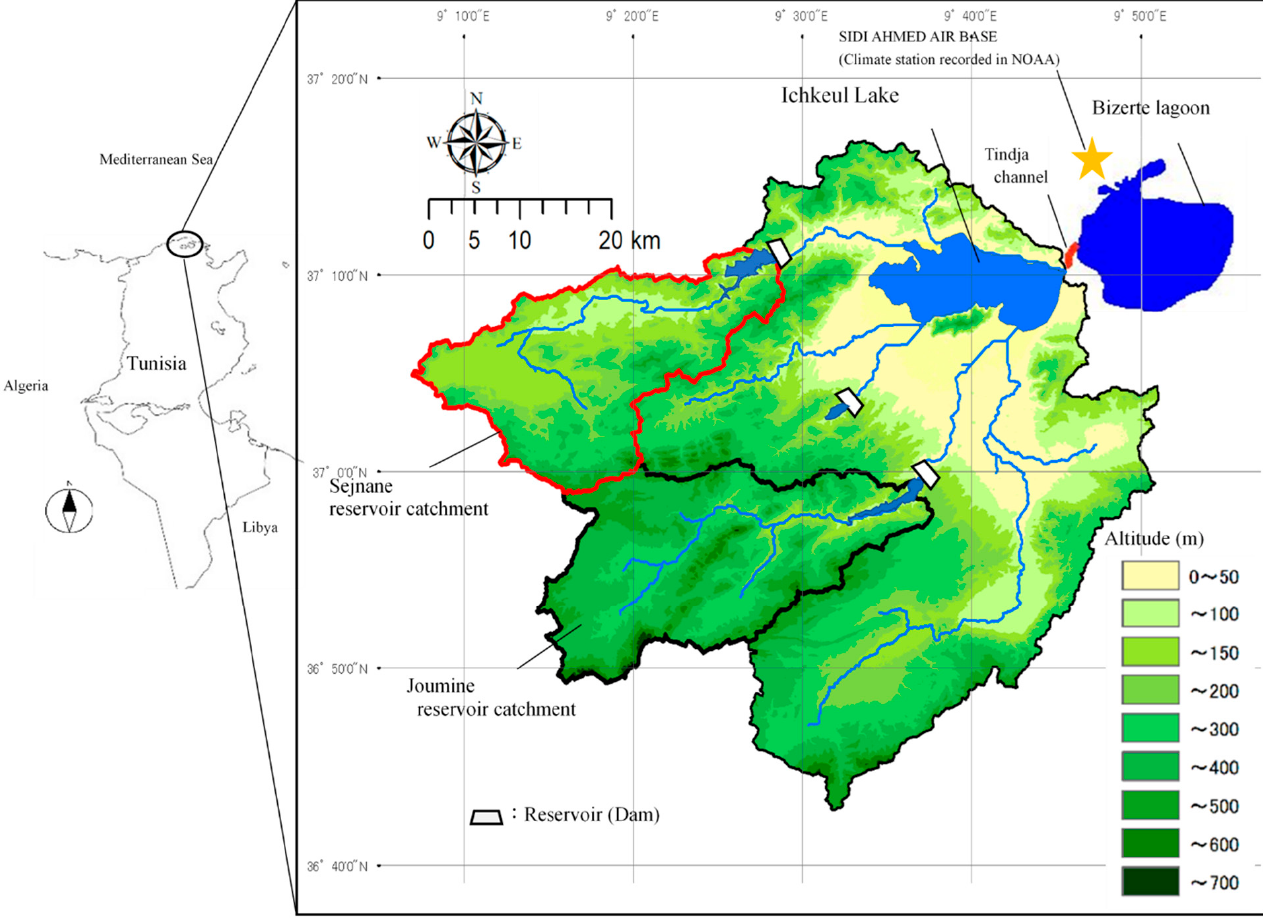
Figure 1. Catchments of Ichkeul Lake.